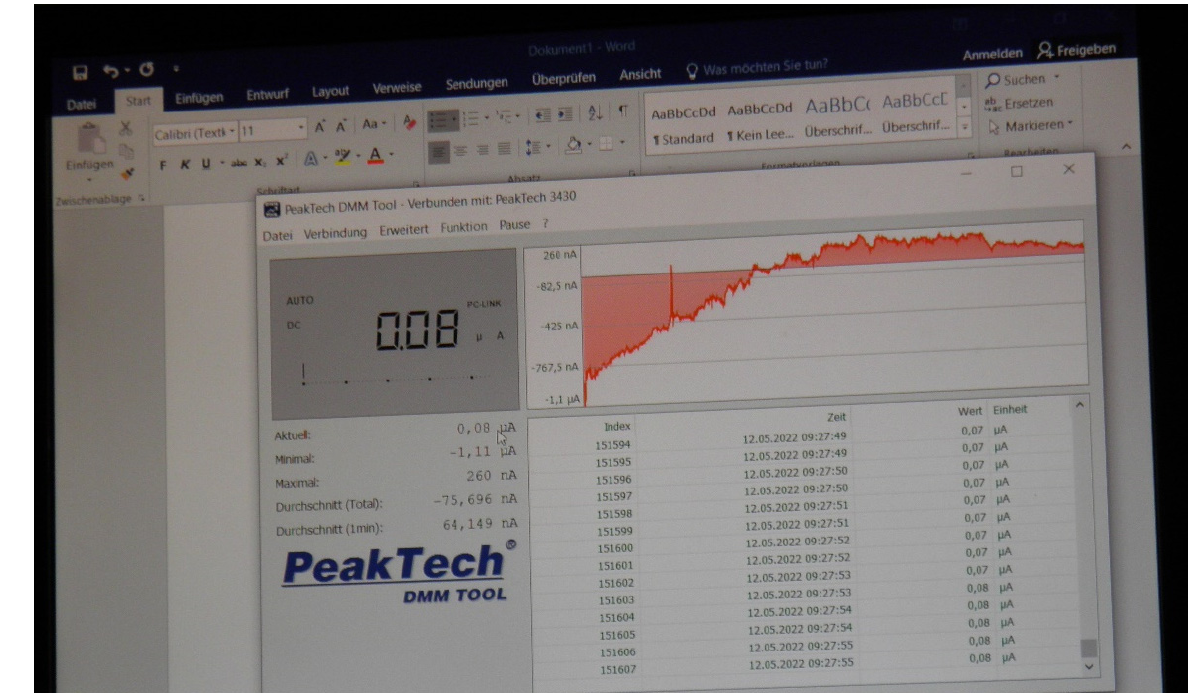
Figure 7. Development of photocurrent in Figure 4 setup over time.